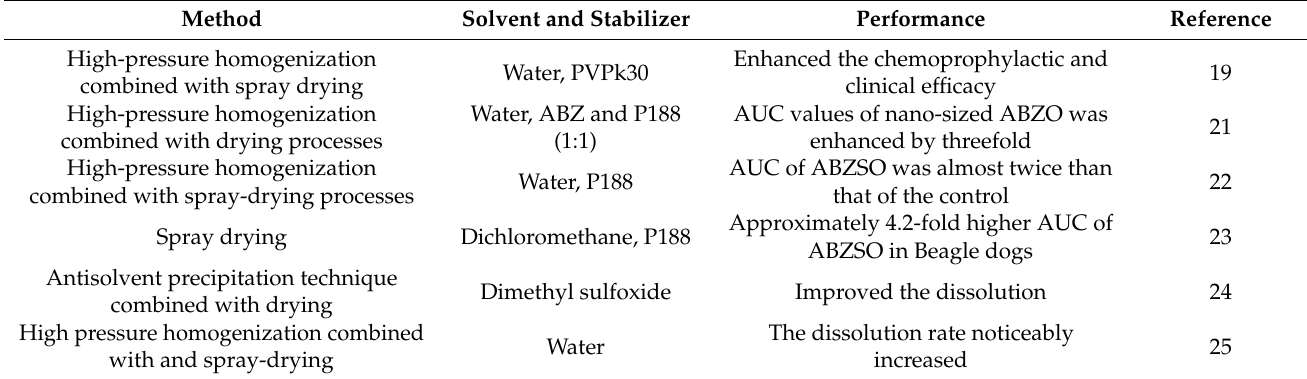
Table 4. The reported preparation methods of ABZ